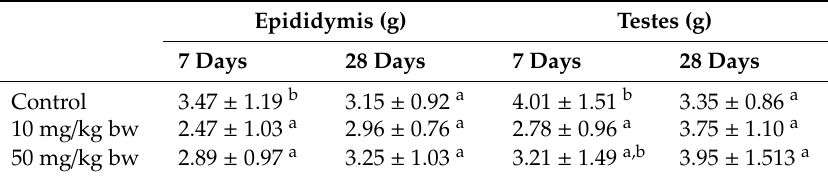
Table 2. Relative weight of organs after administration of Ag-NP to male